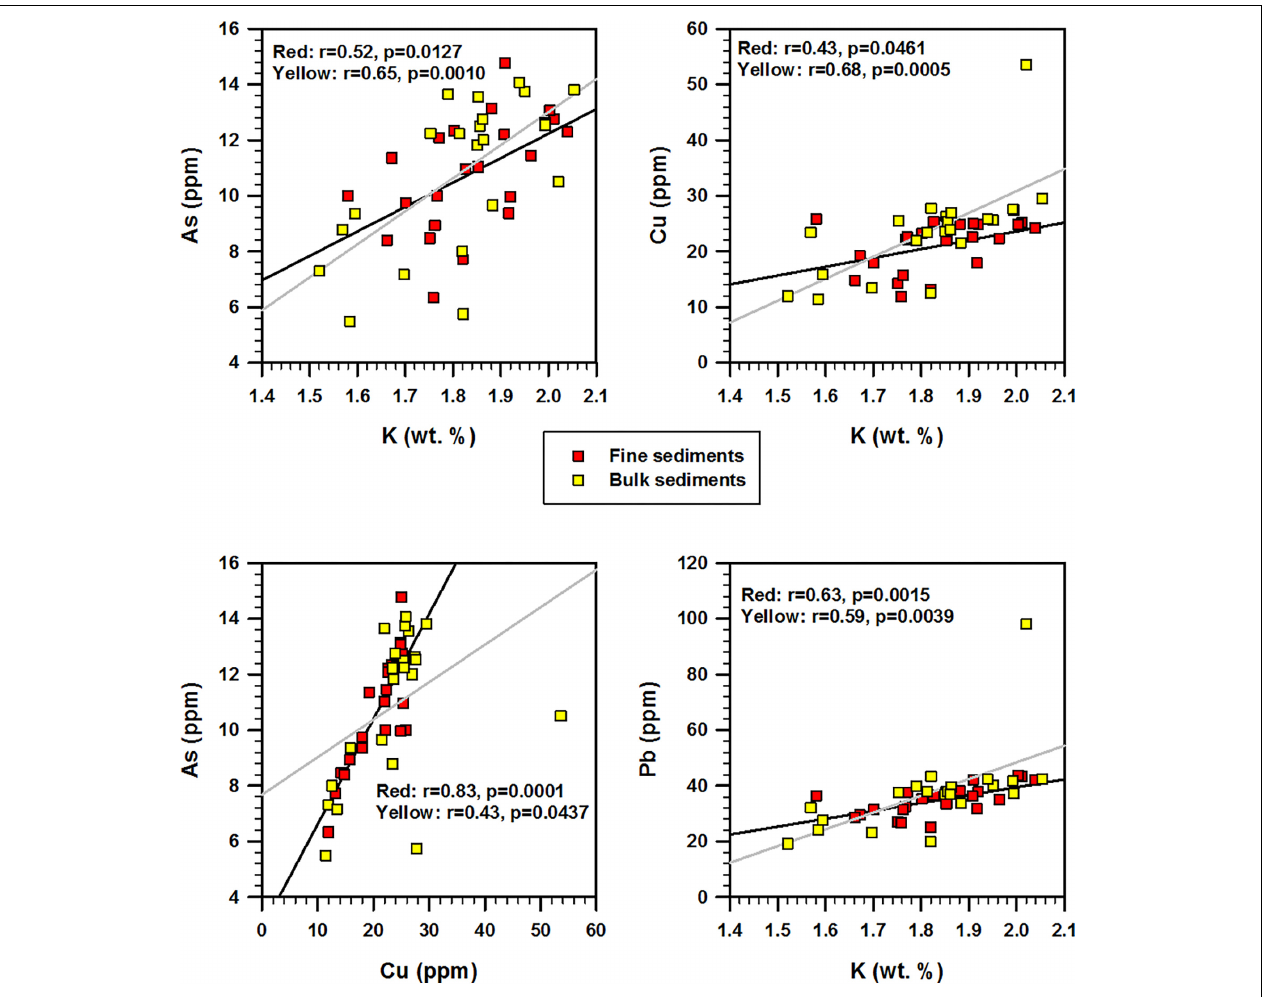
FIGURE 8 | Bi-plots of As vs. K, Cu vs. K, As vs. Cu, and Pb vs. K showing their relationships in fine and bulk fractions of surface sediments, off northwestern Hainan Island, the Gulf of